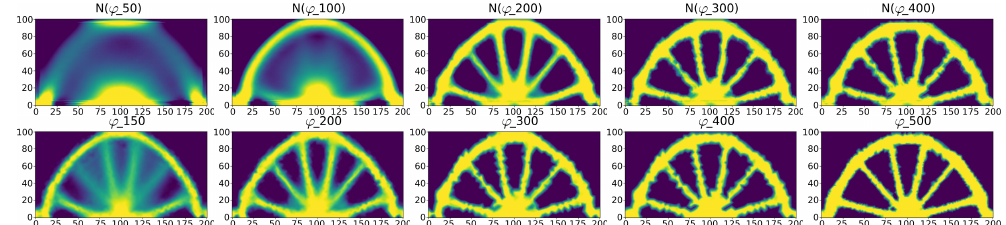
( ϕ n , u ) ( top row ) in comparison with ϕ Figure A6. N 100 n + 1 ; θ CNN